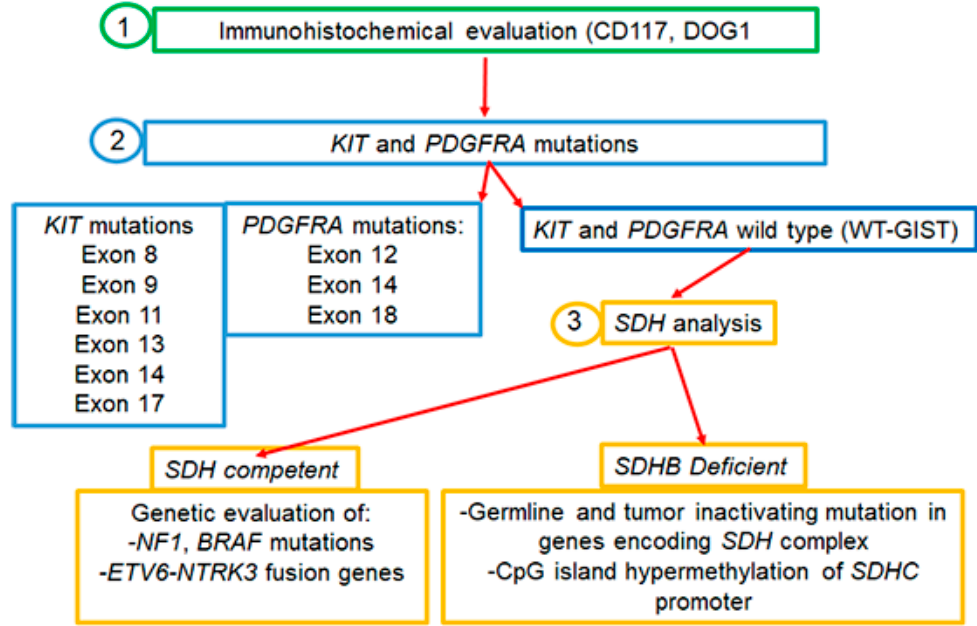
Figure 1. Molecular analysis of